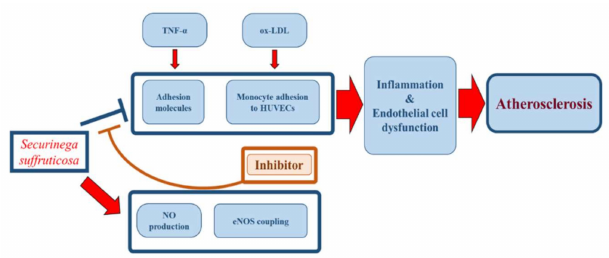
Figure 11. Schematic diagram of the e ff ects of Securiniga su ff ruticosa in vascular